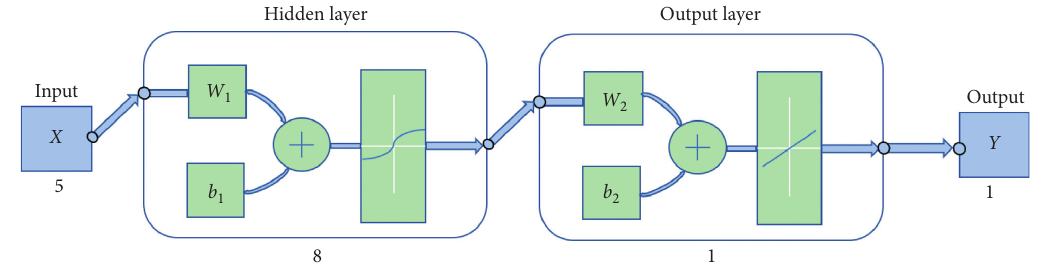
Figure 4: Neural network structure.